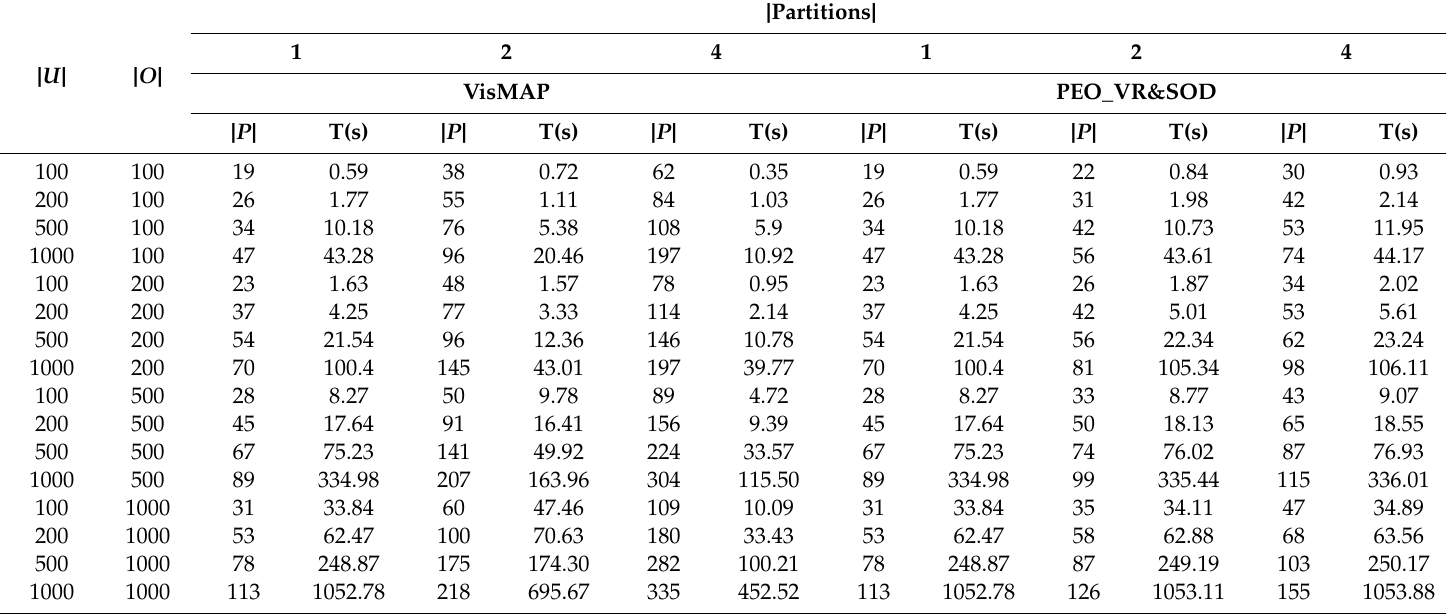
Table 18. Performance comparison with